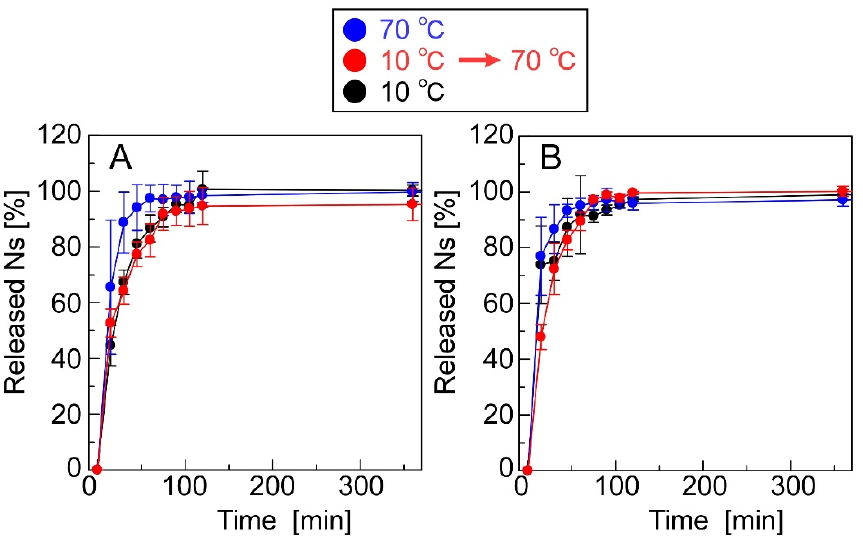
Figure 3. Ns-release profiles of ( A ) CS(Ns) and ( B ) PLL(Ns)